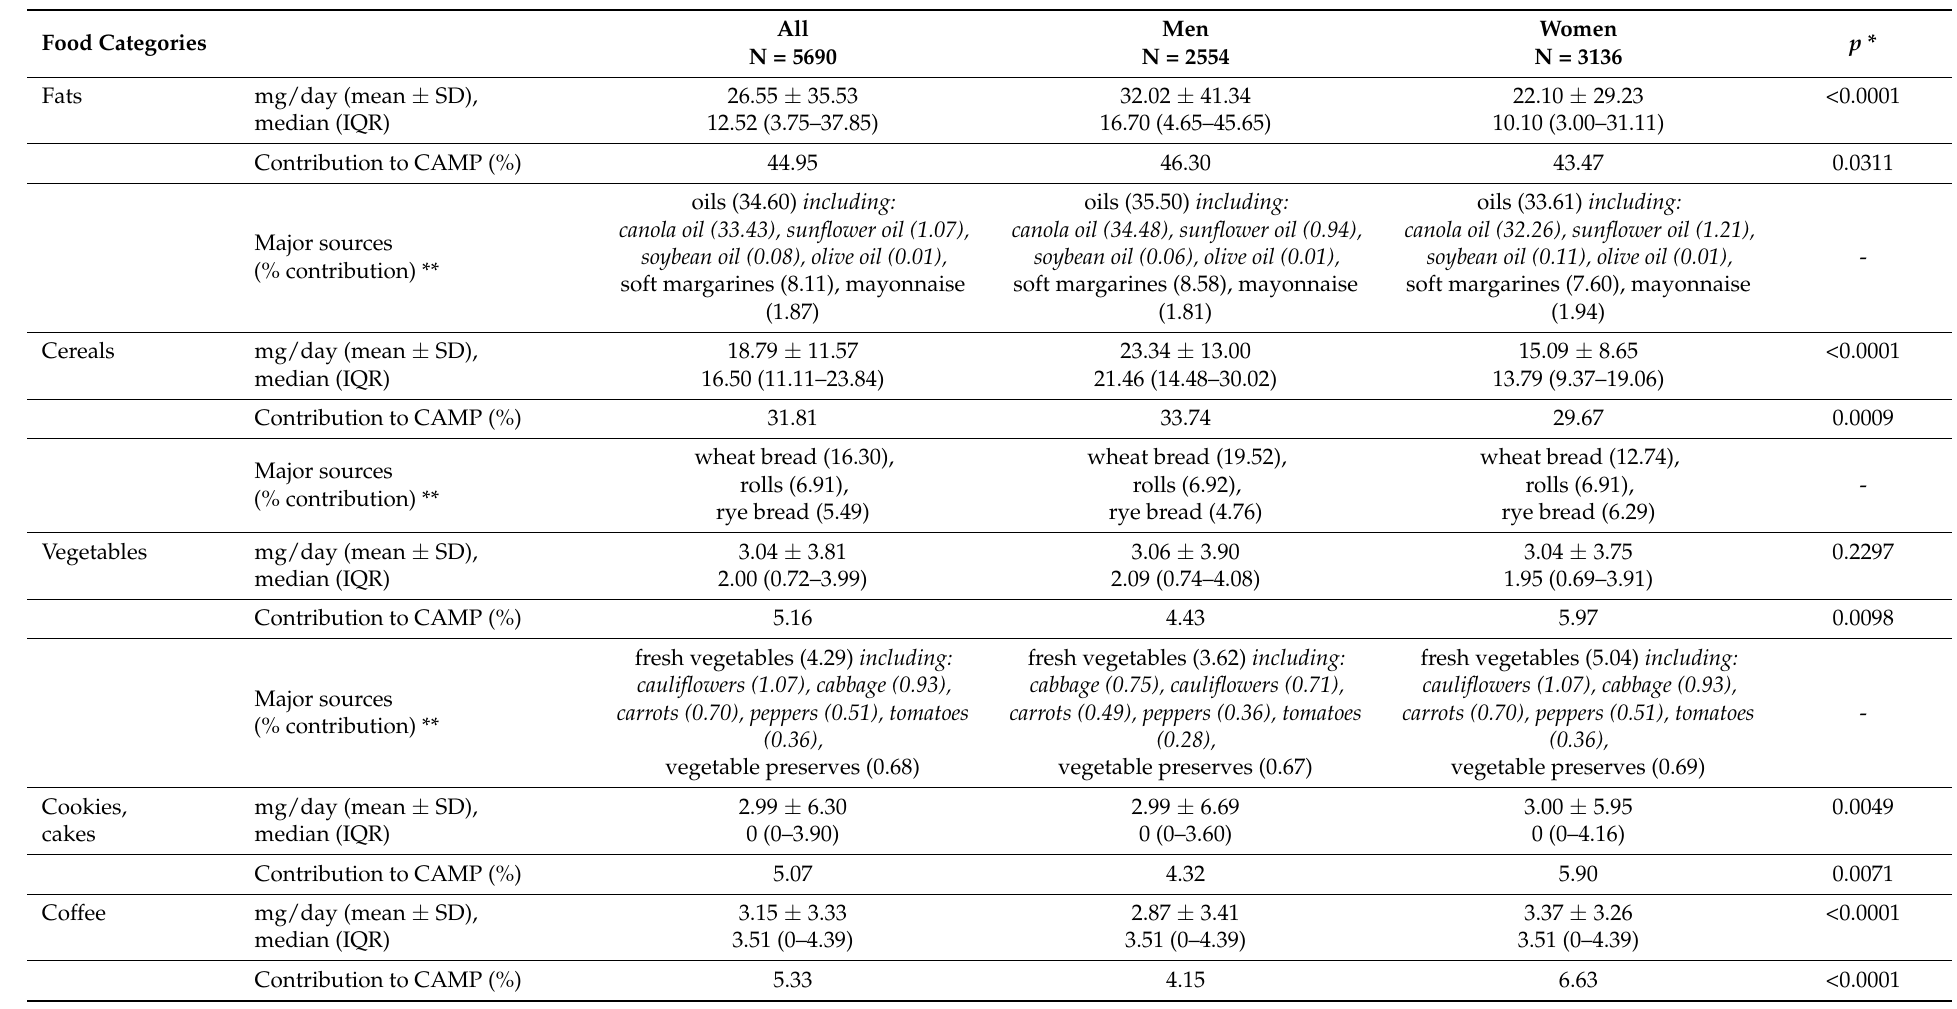
Table 4. Contributions of food categories and individual food products to campesterol intake (CAMP), listed according to diminishing order of contribution. Food